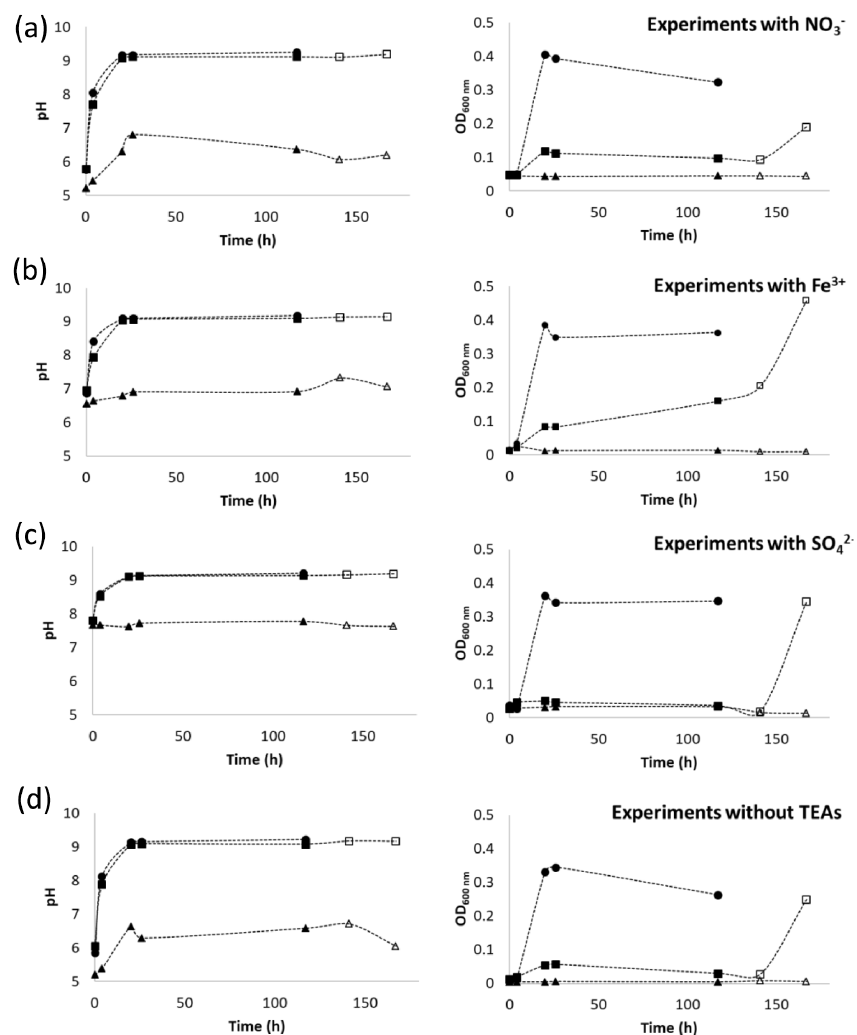
Figure 4. Changes in pH and OD600 over time in anaerobic (square) and aerobic (circle) calcium-exclusive medium for S. pasteurii with (a) NO − , (b) Fe 3 + and (c) SO 2 − as terminal electron acceptors (TEAs); experiments without added TEAs are shown in (d) . Abiotic controls 3 4 (triangle) are also shown. Open markers indicate values for time points after the bottles were opened to the environment allowing oxygen to enter the